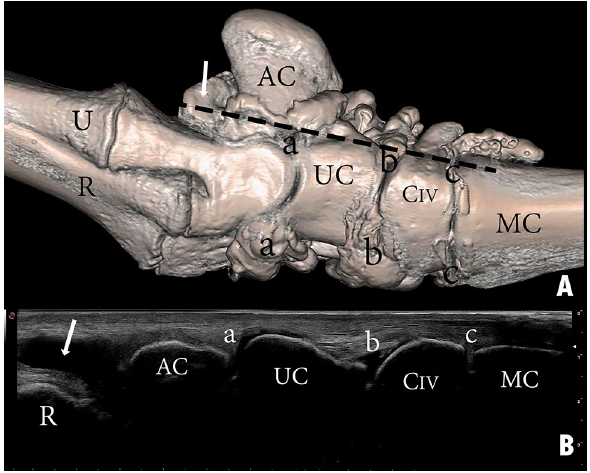
Figure 13. Lateral view of a left carpal joint showing ( A ) three-dimensional reconstruction of the carpal joint (the black dotted line indicates the lateral placement of the ultrasound probe); ( B ) longitudinal composed ultrasound image of the carpal joint. R, the distal end of the radius; U, the distal end of the ulna; AC, accessory carpal bone; UC, ulna carpal bone; CIV, carpal bone IV; MC, metacarpal bone; a, radiocarpal joint cavity; b, intercarpal joint cavity; c, carpometacarpal joint cavity. The white arrow indicates the lateropalmar pouch of the radiocarpal joint.